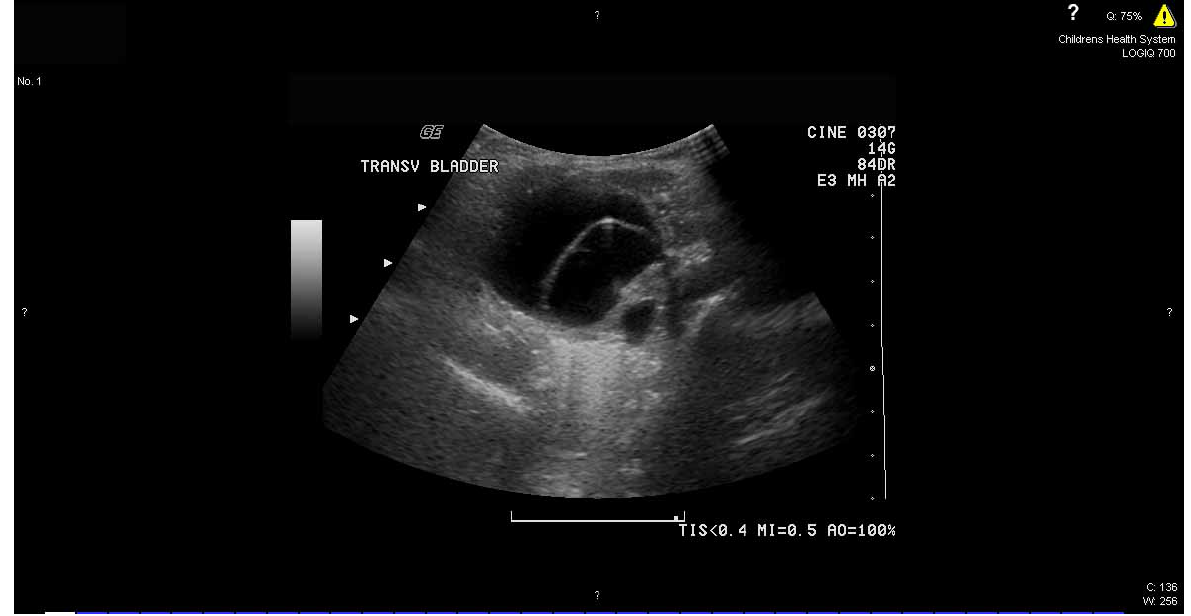
FIGURE 9B . Bladder ultrasound demonstrating ureterocele within the urinary bladder.